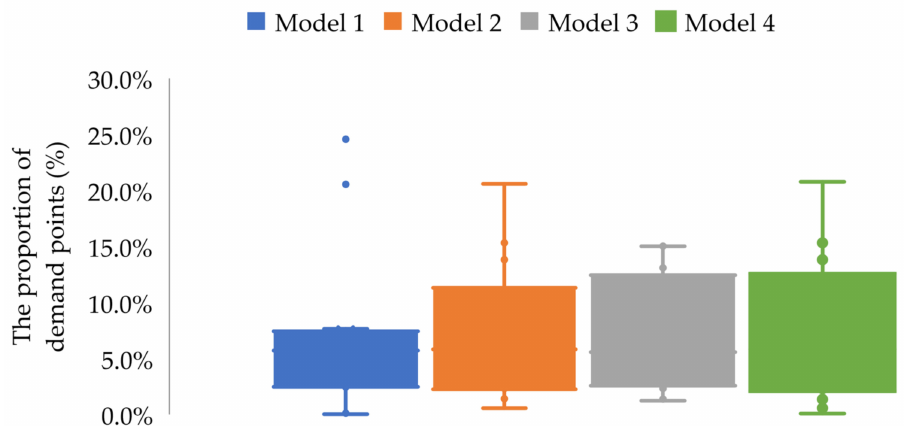
Figure 15. Changes in the proportion of demand points served by the logistics centre before and after optimization (box